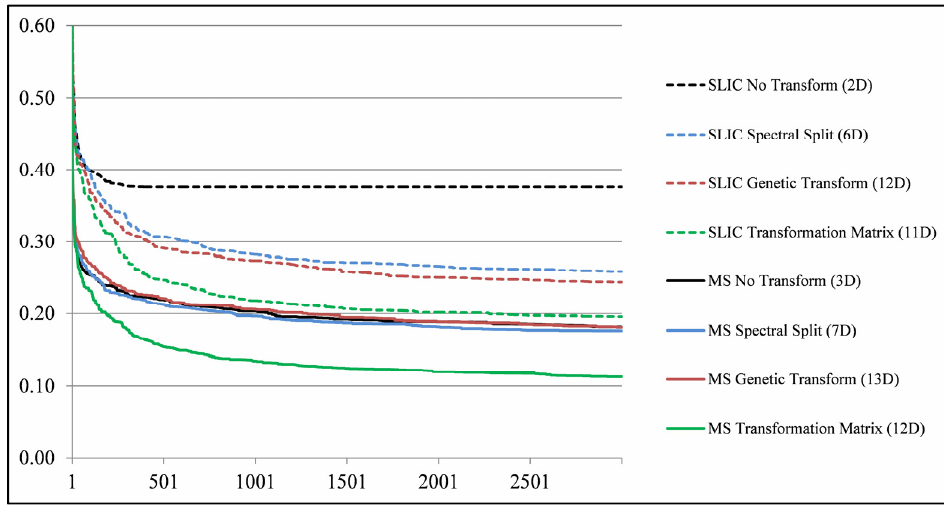
Figure 15. Fitness traces for the two tested segmentation algorithms (SLIC and MS) on the Jowhaar site using the different transformation function strategies. The x-axes delineate search iterations. The y-axes delineate RWJ evaluation